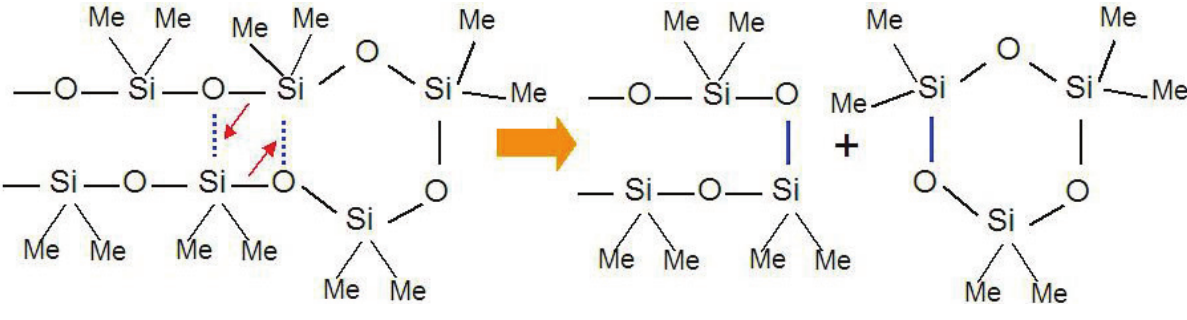
Figure 1. Cyclic oligomer (trimer) expulsion mechanism from a polymethylsiloxane chain during thermal decomposition